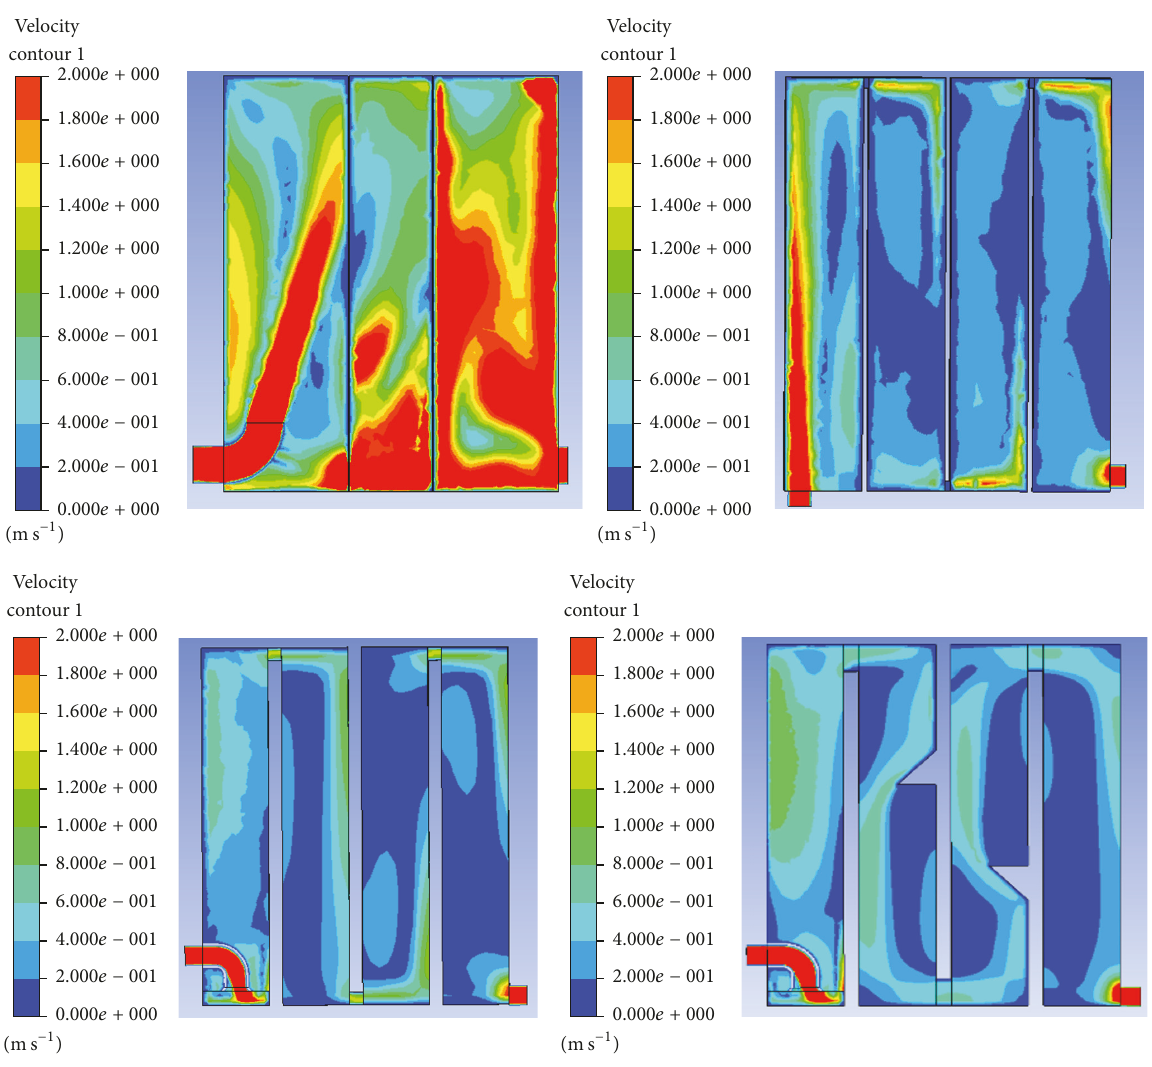
Figure 9: Velocity profiles of first, second, third, and final decay tank models.